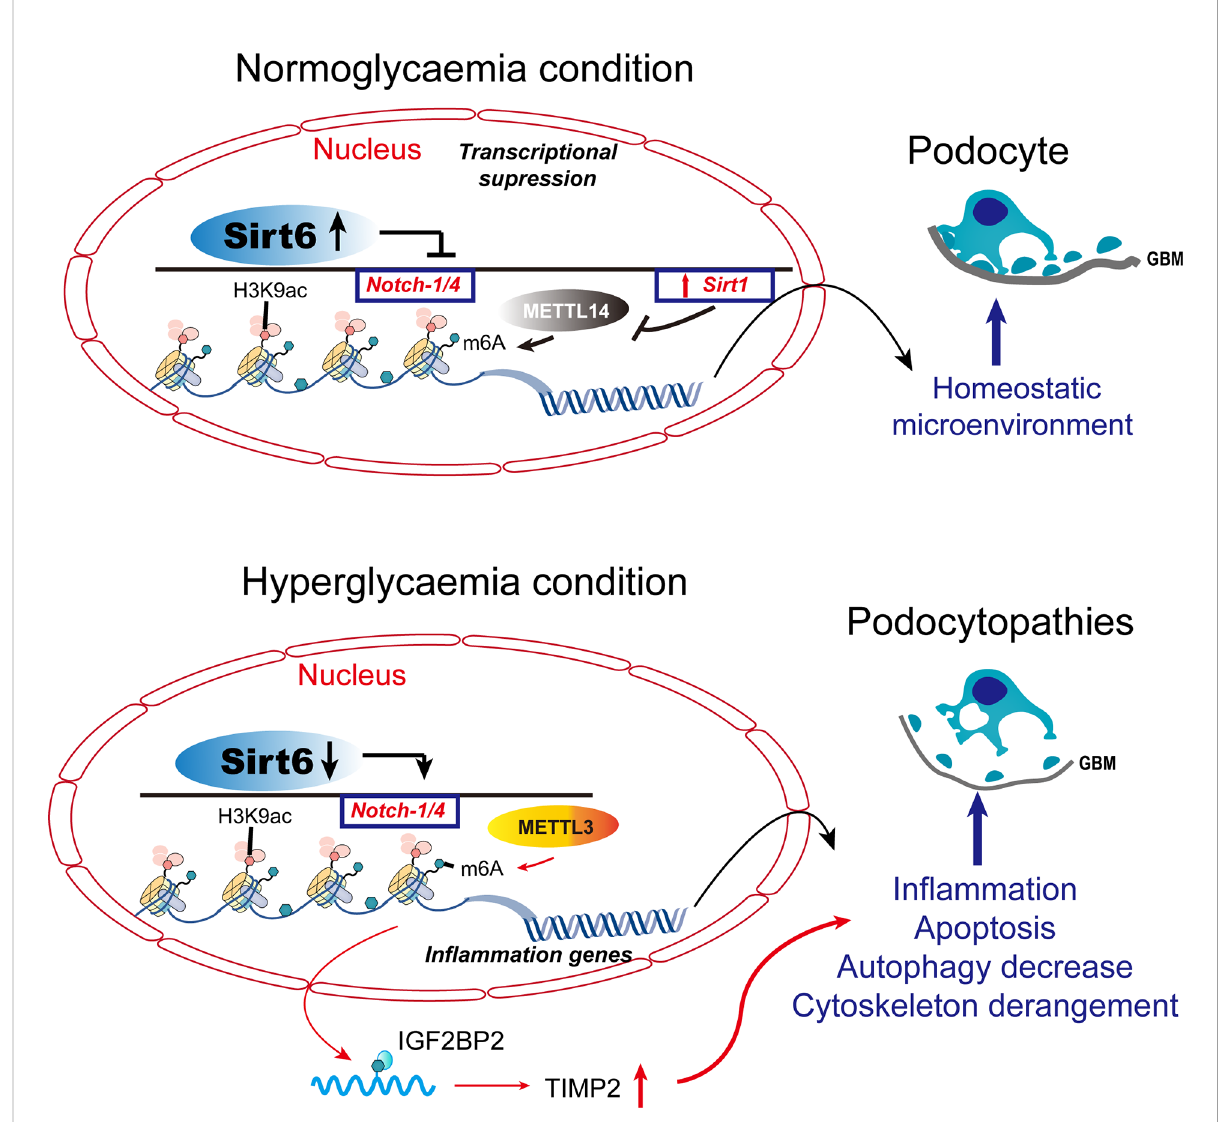
FIGURE 2 Histone modi fi cations and DNA methylation in podocytopathies. Under normal conditions, Sirt6 inhibits the transcription of Notch1 and Notch4 by decreasing H3K9ac levels in the promoter regions of Notch1 and Notch4 . METTL14 de fi ciency inhibits Sirt1 mRNA m6A modi fi cation, thereby increasing Sirt1 levels in normal podocytes. METTL3 modulates the m6A modi fi cation of TIMP2 in an IGF2BP2-dependent manner and exerts pro-in fl ammatory and -apoptotic effects. TIMP2, tissue inhibitor of metalloproteinase 2; IGF2BP2, insulin-like growth factor 2 mRNA binding protein